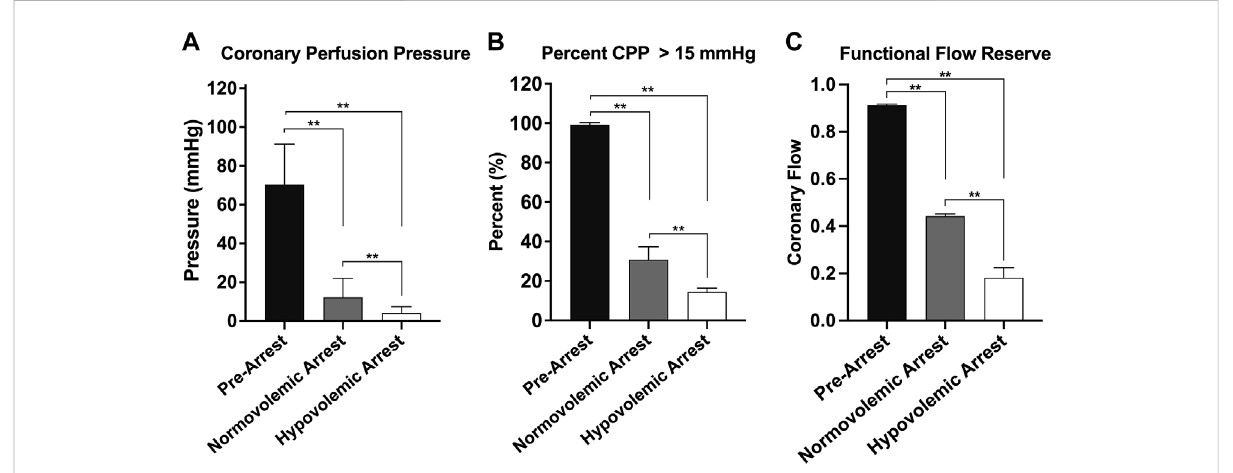
FIGURE 4 | Graphical representations of the three cohorts during open cardiac massage: normovolemic pre-arrest, normovolemic arrest, and hypovolemic arrest. (A) Mean cerebral perfusion pressure (CoPP), (B) the percentage of pressure tracing segments where CoPP > 15 mmHg, and (C) thefunctional fl owreserve.Statisticalsigni fi cancedenotedongraph.Statisticalsigni fi canceofp < 0.05isdenotedas*andp < 0.001isdenotedas**.